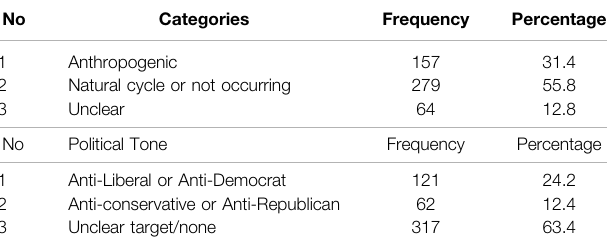
TABLE 1 | The main categories and political tone of the most retweeted